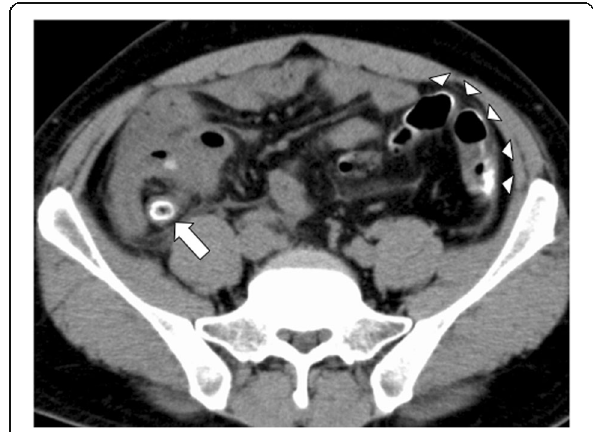
Fig. 1 Mural calcification of the appendix and descending colon.